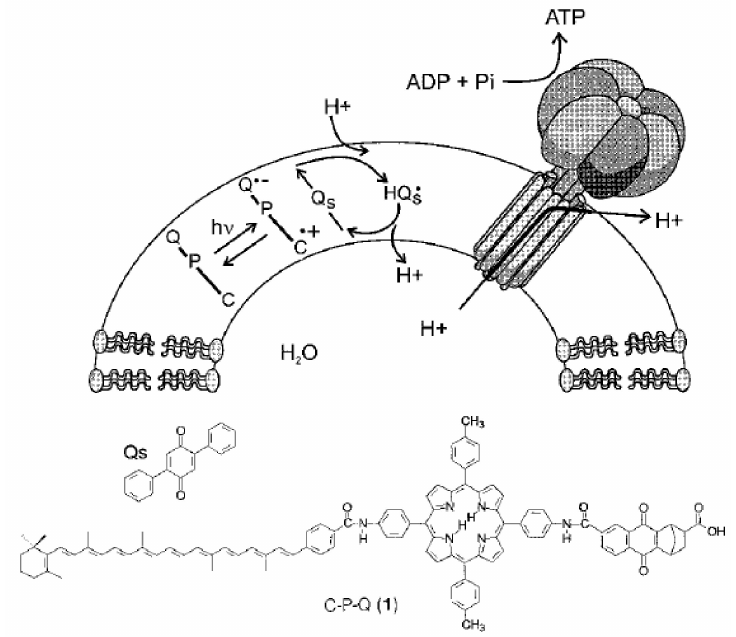
Figure 7. The chloroplastic F 0 F 1 -ATP synthase and an artificial photosynthetic apparatus based on a molecular triad were reconstituted into